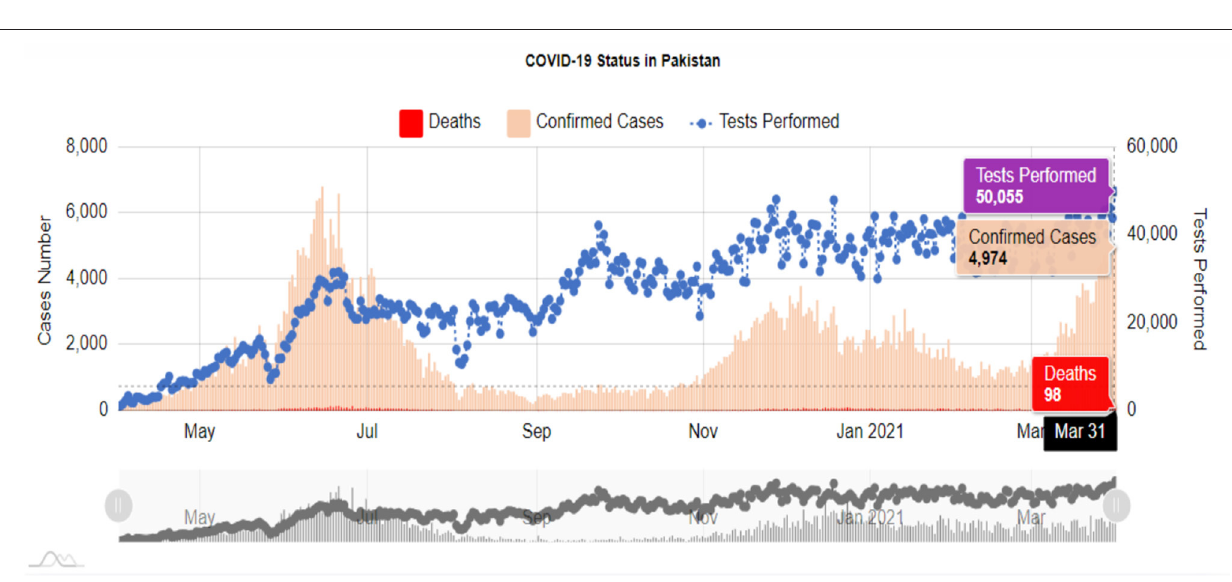
FIGURE 2 | Report of daily deaths due to Covid-19 during March 2021. Values show an exponential growth pattern since its outbreak on 26th February 2020 (data taken from the Pakistan statistics of NCOC,